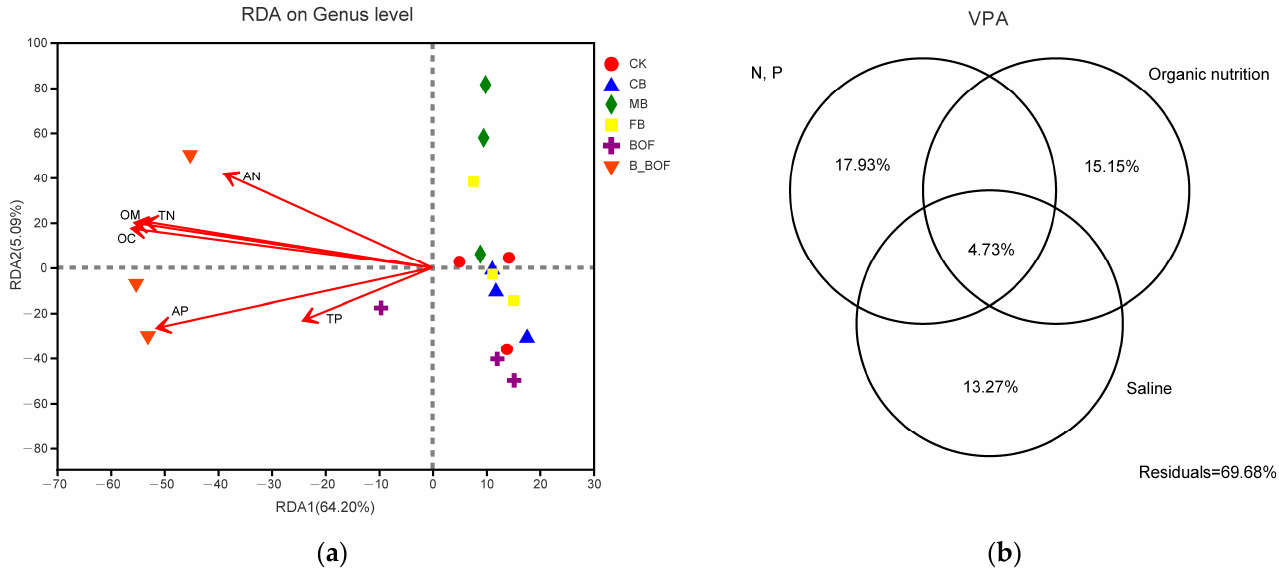
Figure 7. Relationship between soil characteristics and soil bacterial community. ( a ) RDA, two first components (PCoA 1 and PCoA 2), which represented 69.29% of the variation, were plotted. ( b ) VPA, variation partitioning (% variation explained) of rhizosphere bacterial community in relation to combined environmental variables.